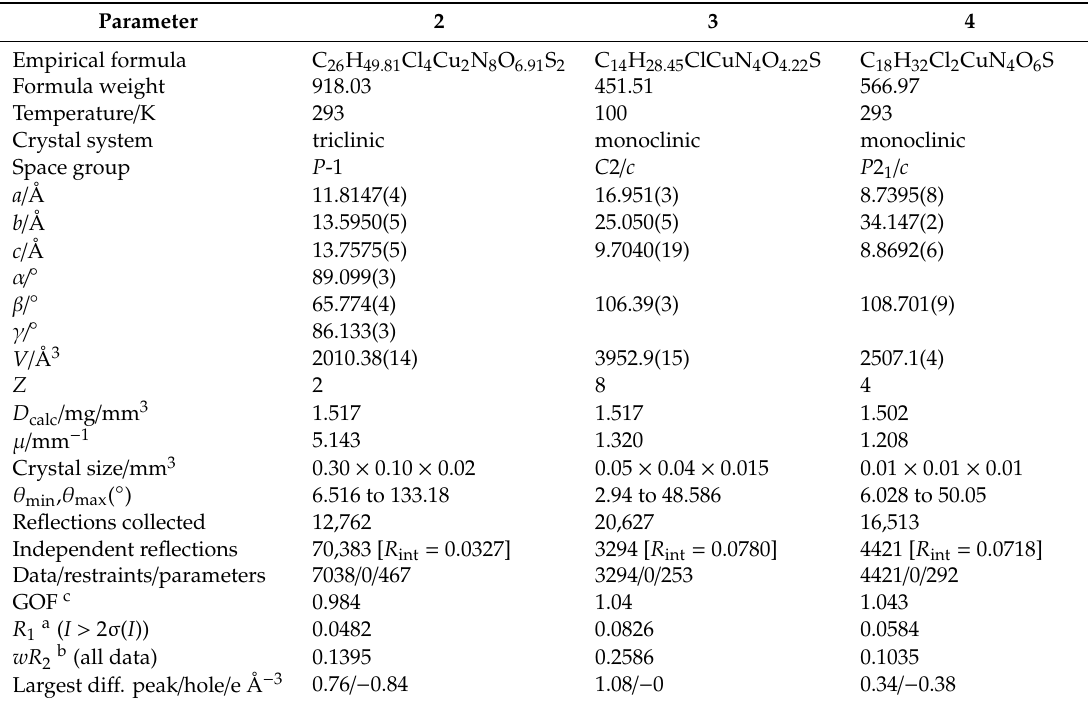
Table 1. Crystallographic data for 2 – 4